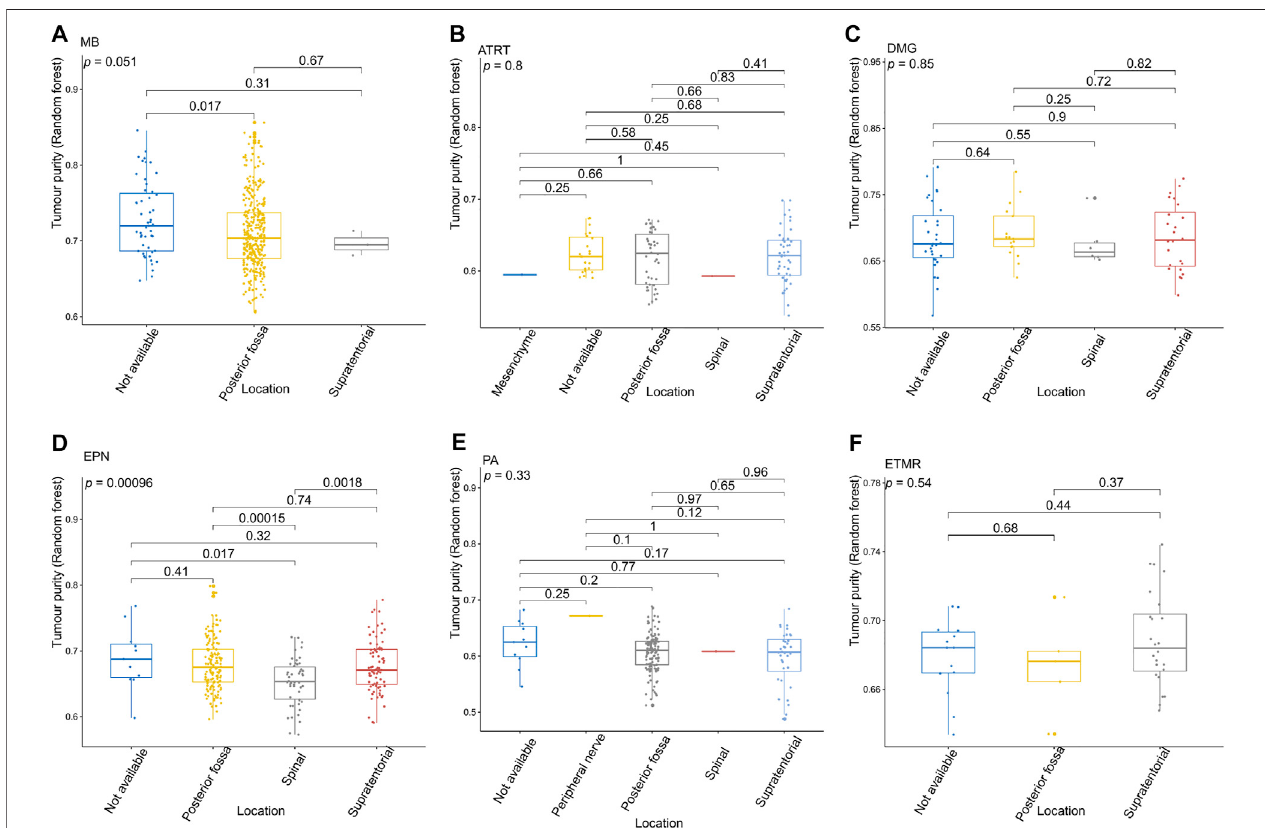
FIGURE4| RelationshipbetweenthetumorpurityofeachpediatricCNStumorandthetumorlocationintheGSE90496dataset. (A) Boxplotofthetumorpurityin medulloblastoma(MB)samplesbythetumorlocation; (B) boxplotofthetumorpurityinatypicalteratoma/rhabdoidtumorsamplesbythetumor location; (C) boxplotof thetumorpurityindiffusemidlinegliomasamplesbythetumorlocation; (D) boxplotofthetumorpurityinependymoma(EPN)samplesbythetumorlocation; (E) boxplot ofthetumorpurityinpilocyticastrocytomasamplesbythetumorlocation; (F) boxplotofthetumorpurityinembryonictumorsofmultilayeredrosettesbythetumor